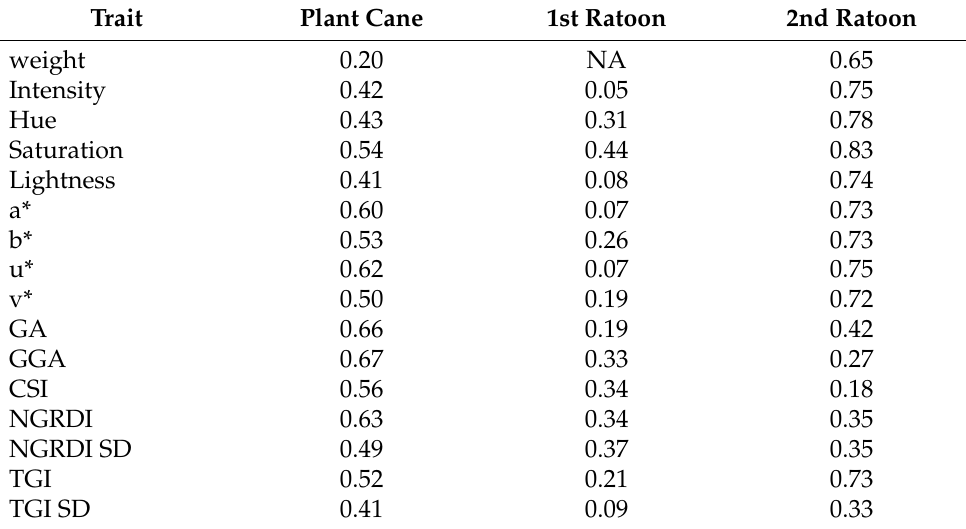
Table 5. Heritabilities by year of plot weights and CIELab indices derived from RGB remote sens- ing images.